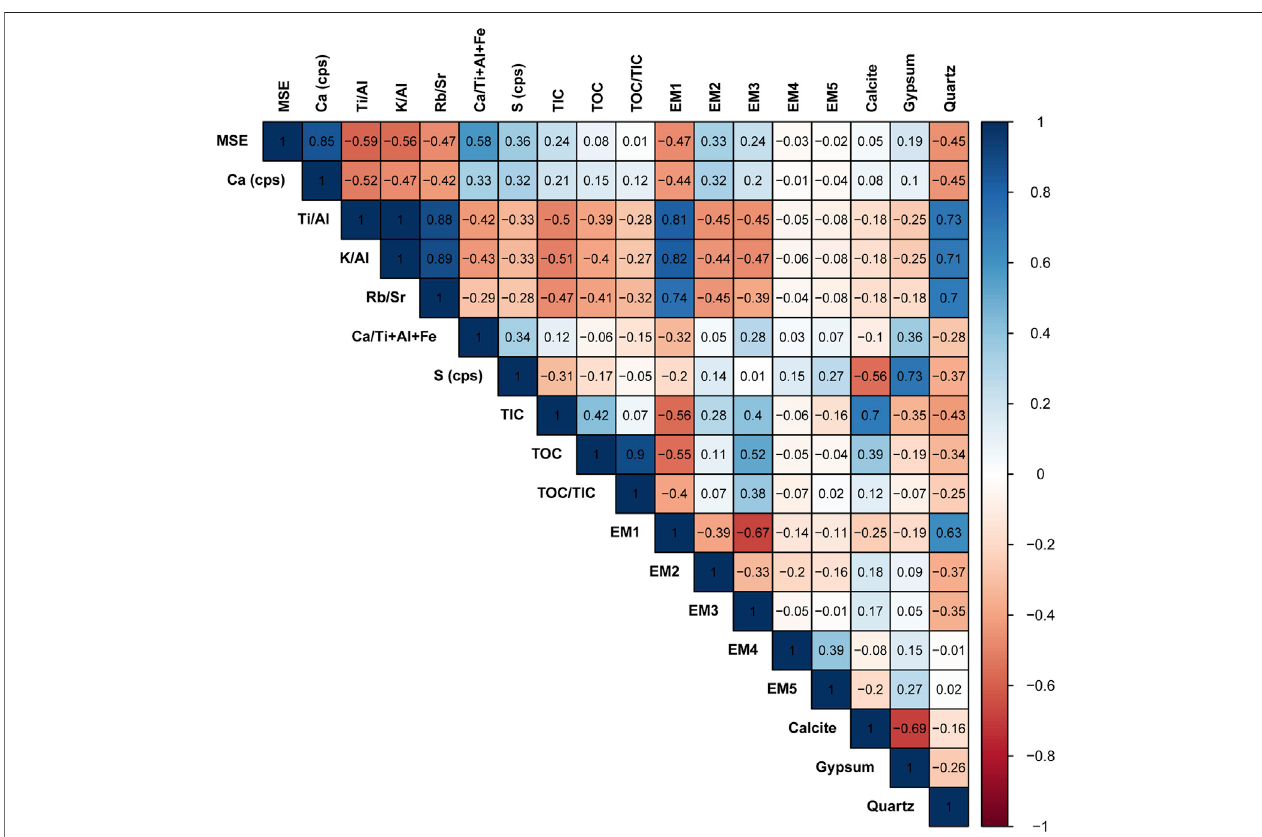
FIGURE8| APearsoncorrelationmatrixofelementalabundanceandratios,mineralabundance,differentendmembersofgrainsize,MS,andTOC/TICdataofthe GBW composite core.